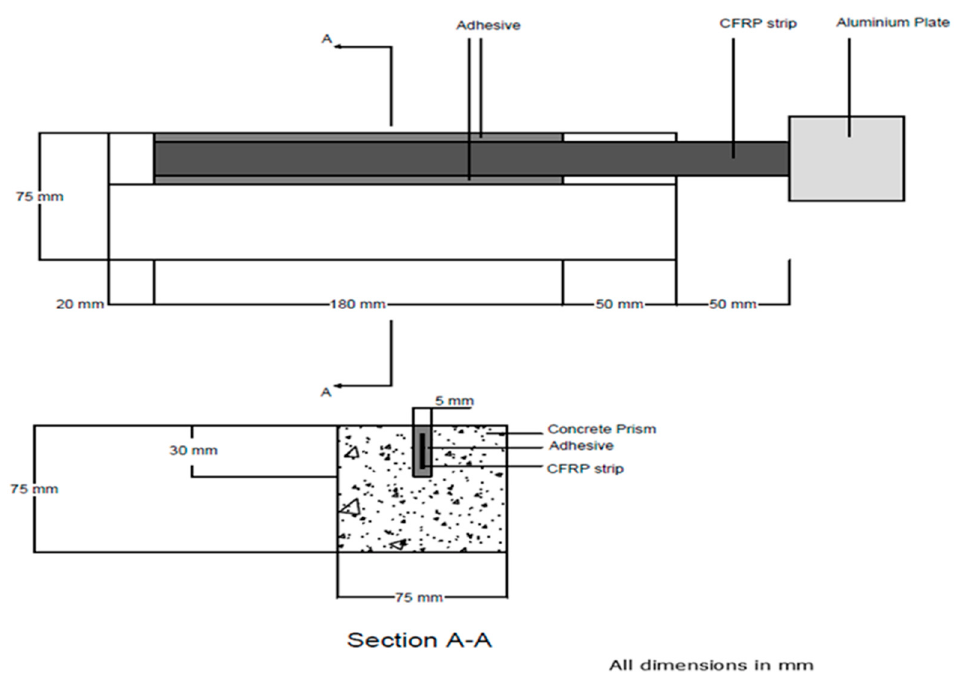
Figure 1. Specimens’ details.